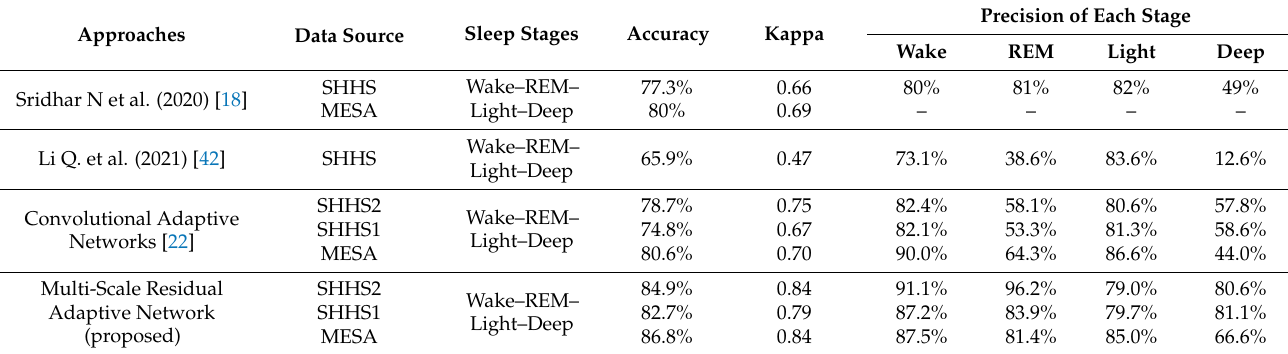
Table 4. Comparison with other sleep stage classification approaches based on